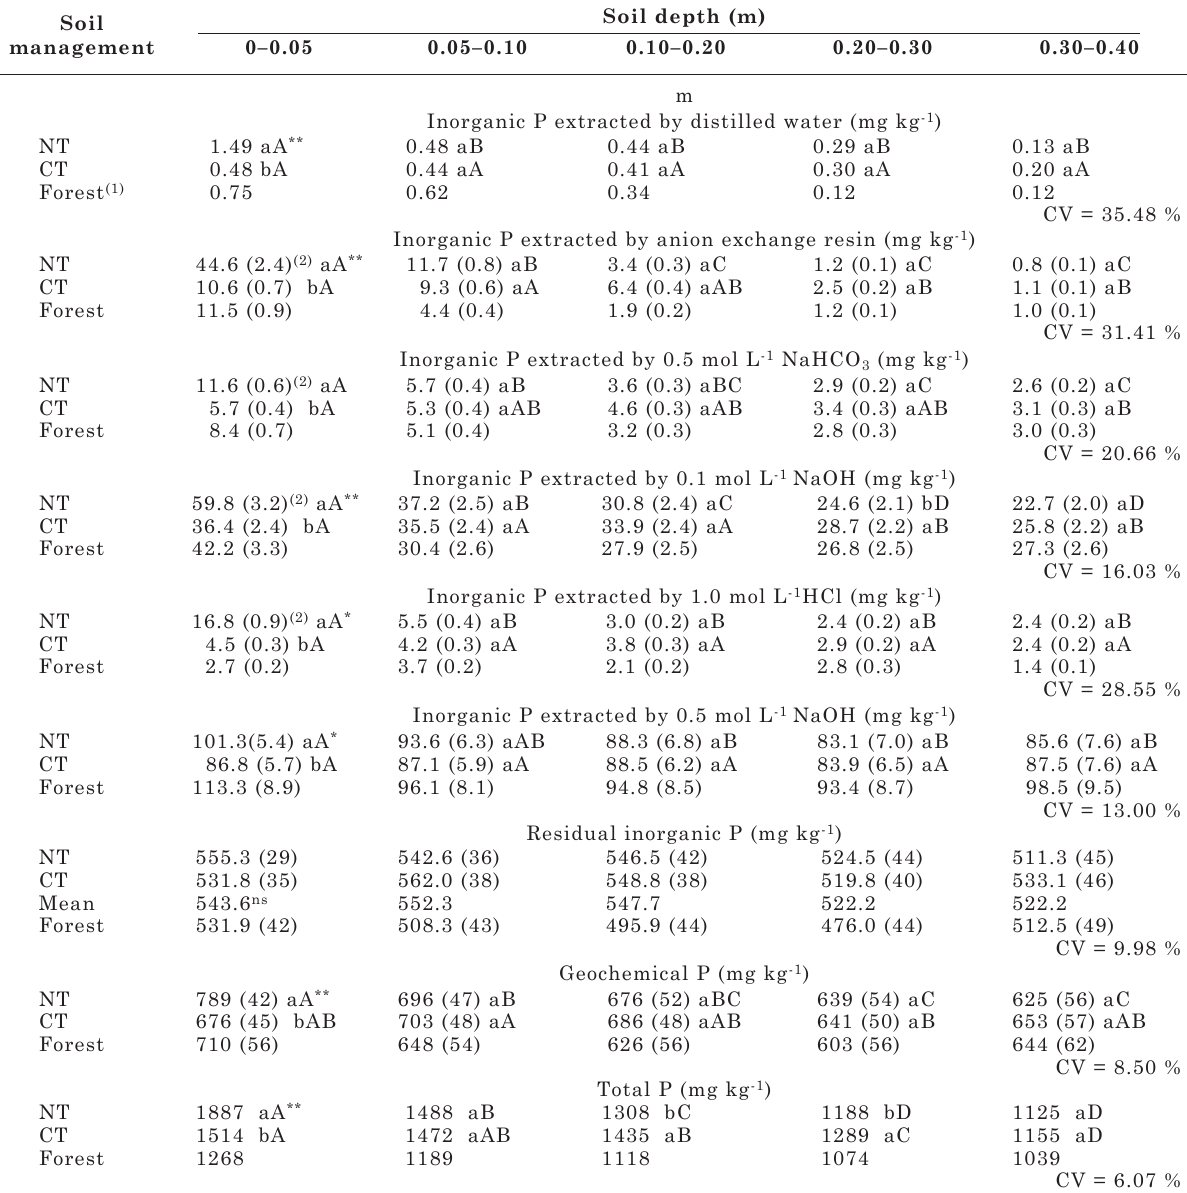
table 3. Inorganic and total phosphorus forms after 23 years of different soil managements of a rhodic